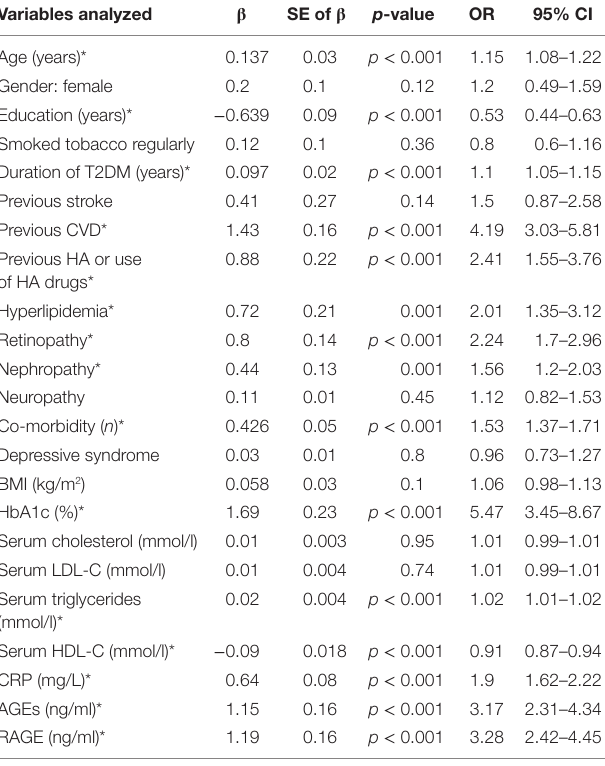
TaBle 4 | assessment results of the risk of having Mci in a simple logistic regression model in elderly patients with type 2 diabetes. Variables analyzed